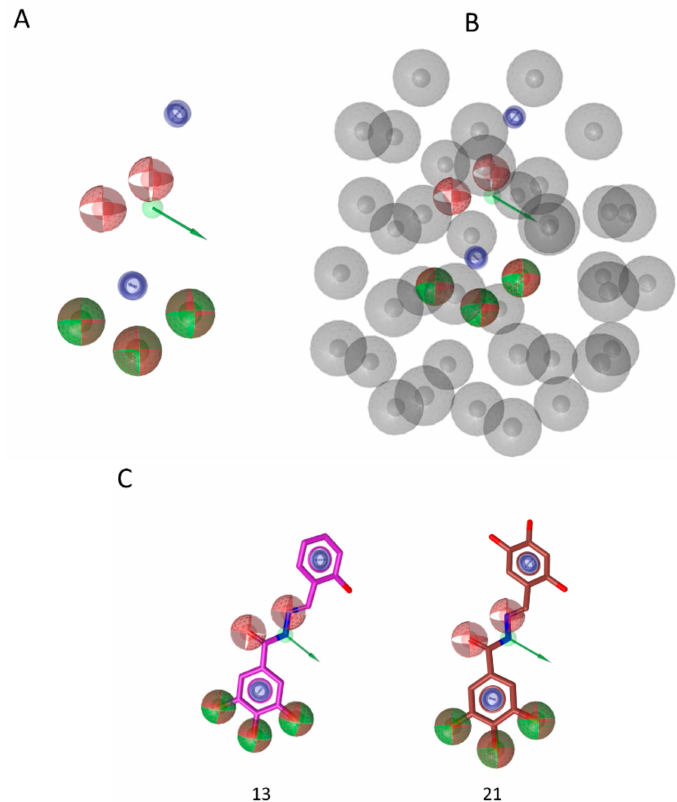
Figure 6. ( A ) Share ligand-based pharmacophore model; ( B ) Share-based pharmacophore model with excluded volumes; ( C ) pharmacophore matching of compound 13 and 21 . Red sphere, H bond acceptor; green sphere and arrow, H bond donor; blue circle, aromatic